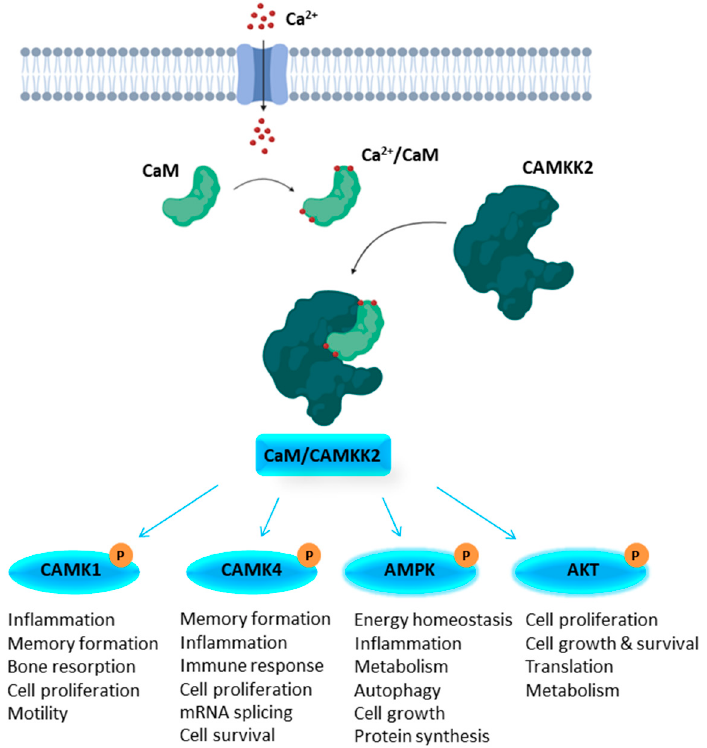
Figure 1. The CAMKK2 signaling pathway. Activation of CAMKK2 mediates downstream signaling of CAMK1, CAMK4, AMPK, and AKT; (adapted from [11,12,17]).